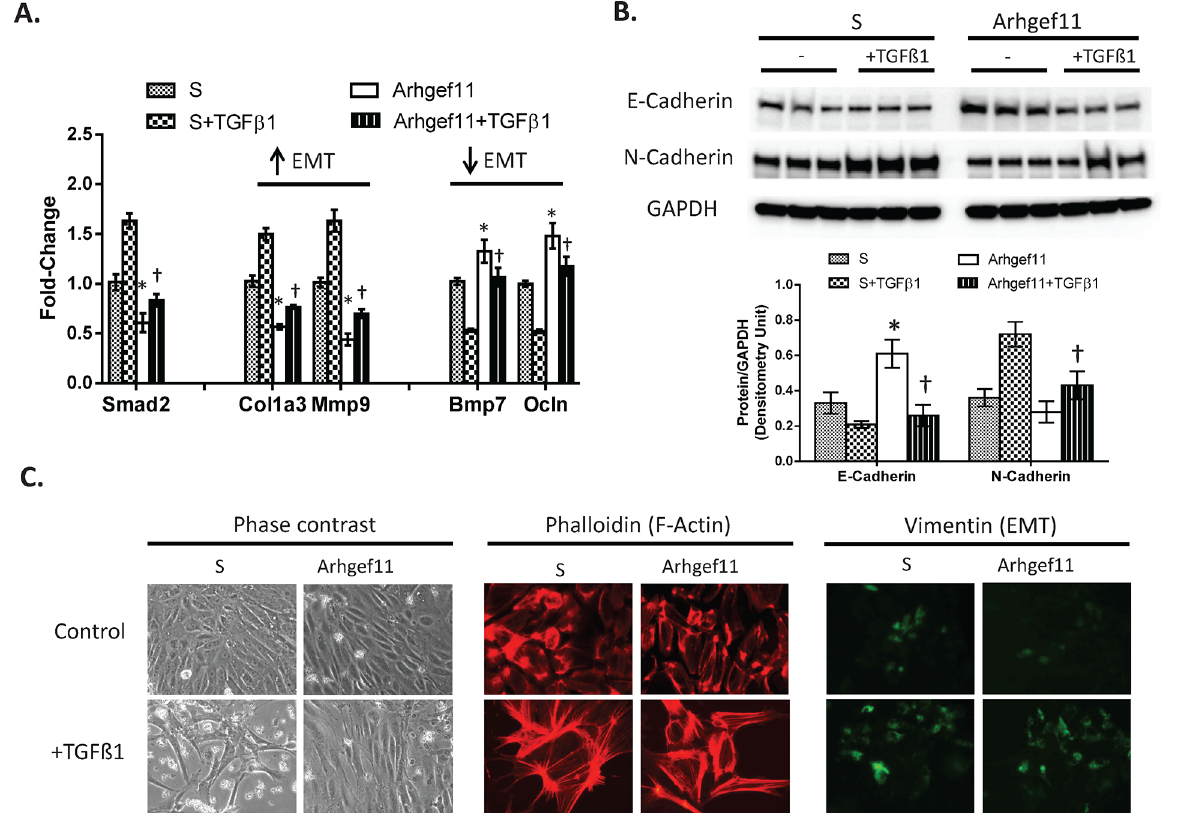
Fig 7. Real-time PCR and western analysis of TGFß-1 induced epithelial mesenchymal transition (EMT) and impact on RhoA-Rock pathway in primary proximal tubule cell (PTC). Primary PTC cells (day 5, > 60% confluent) were grown from S and Arhgef11-congenic kidney (at 4 weeks of age) and treated with TGFß-1 (10 ng/ml) for 48 hrs. ( A ) Real-time PCR of markers indicative of EMT. ( B ) Western analysis and densitometry of E-Cadherin and N-Cadherin EMT markers. ( C ) Representative phase contrast and immunofluorescence of stress fibers formation (F-Actin) and Vimentin (EMT markers) between S and Arhgef11-congenic PTC exposed to TGFß-1. n = 4 – 6 independent samples, * p < 0.05 versus S, † p < 0.05 versus S+ TGFß-1. Error bar are ±